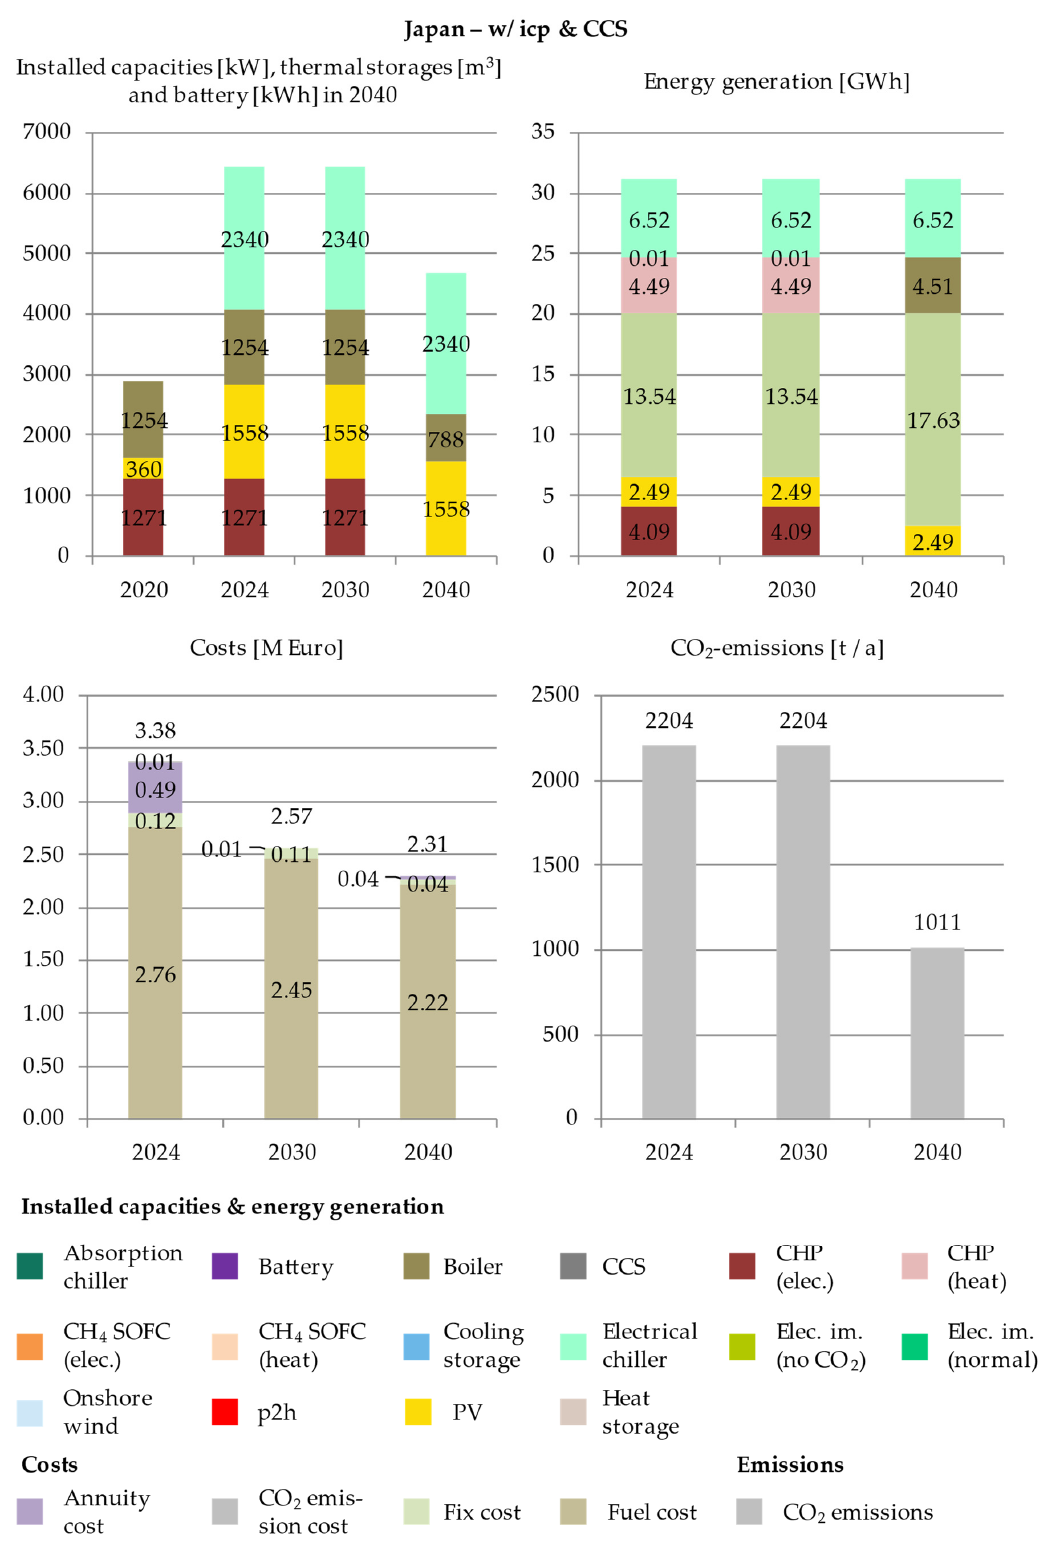
Figure A8. Detailed results for the Japanese “w/ICP and CCS” scenario.